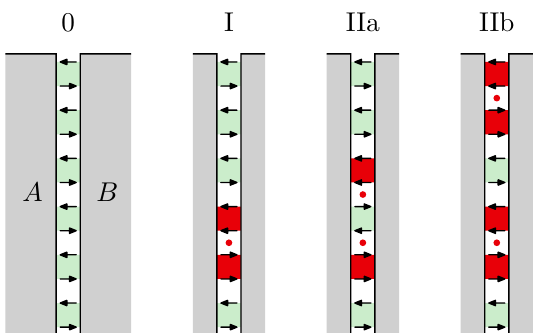
Figure 10: Spin configurations s ( , for a vertical cut m = 1,..., L , that we m , n + 1 / 2 ) y associate with the lowest levels 0–IIb of the entanglement spectrum in the RVBS (see Fig. 9). Oriented plaquettes on the resonant sublattice (green) can be destroyed (red) by virtual plaquette-flips in the opposite sublattice (red